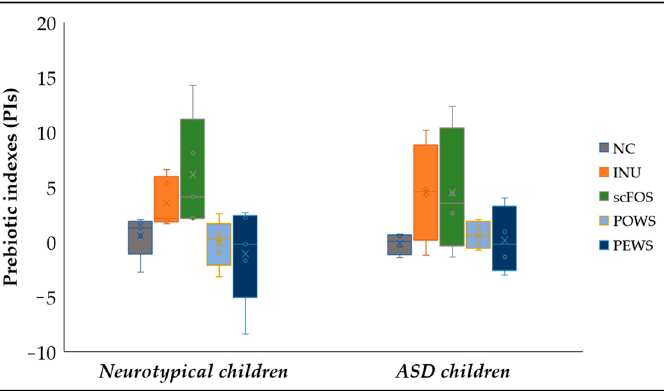
Figure 1. Prebiotic indexes for each substrate in autistic and neurotypical children. Data are presented as Boxplots, with the horizontal line representing the median and the whiskers representing the minimum and maximum values.